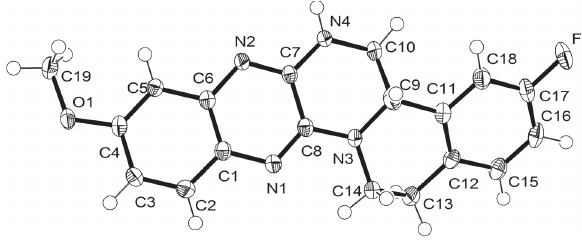
Table 1: Data collection and handling.